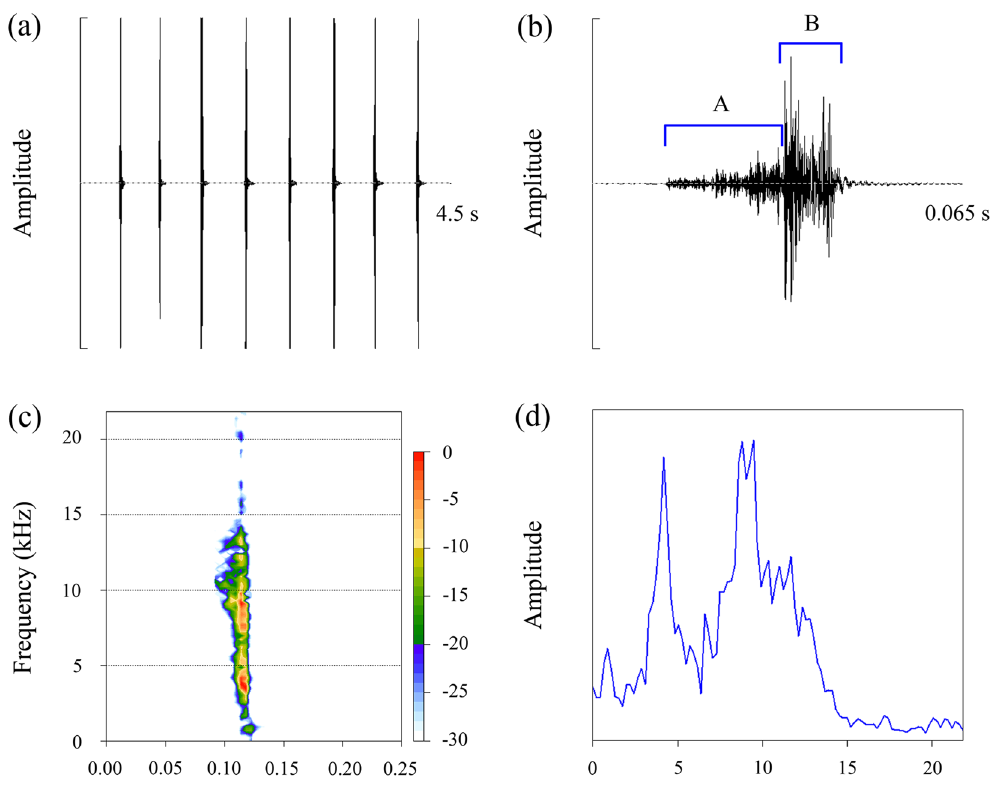
Figure 3. Acoustic structure of the attractive sounds. ( a ) Oscillogram of eight sounds. ( b ) Detailed oscillogram of a single sound. ( c , d ) Spectrogram (time vs frequency vs amplitude, colour amplitude scale given on the right) and mean spectrum (frequency vs amplitude) of a single